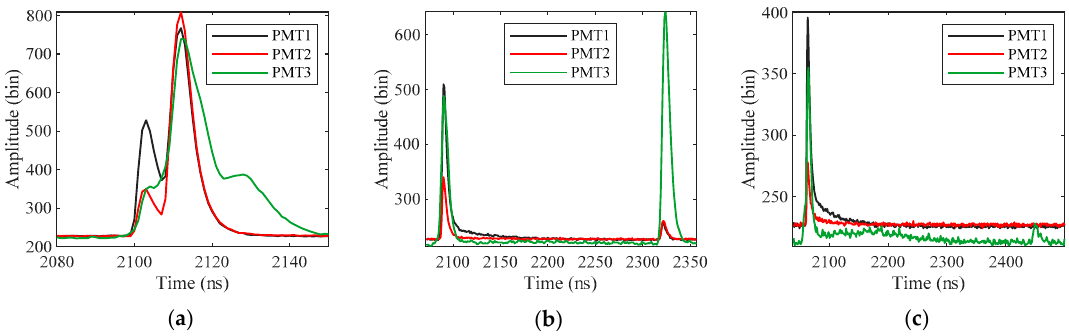
Figure 19. The received waveforms in PMT1, PMT2 and PMT3 with depths of ( a ) 1.4 m, ( b ) 35.1 m and ( c ) 57.8 m.